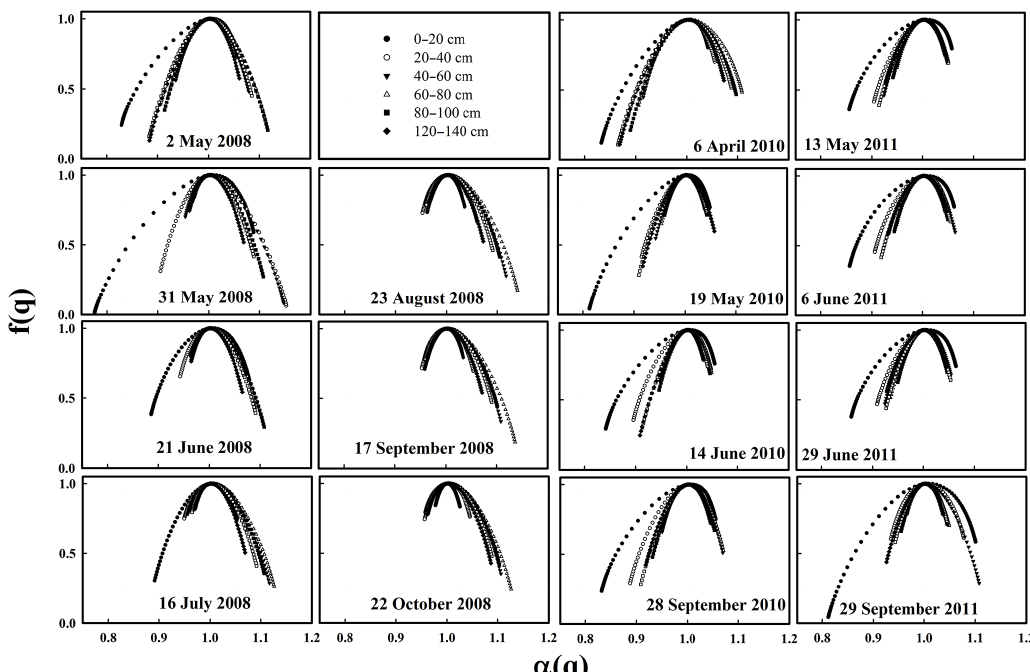
Figure 6. Multifractal spectra of soil water storage spatial series measured at each 20cm soil layer down to 140cm in 2008, 2010 and 2011 for a range of q ( − 15 to 15 at 0.5